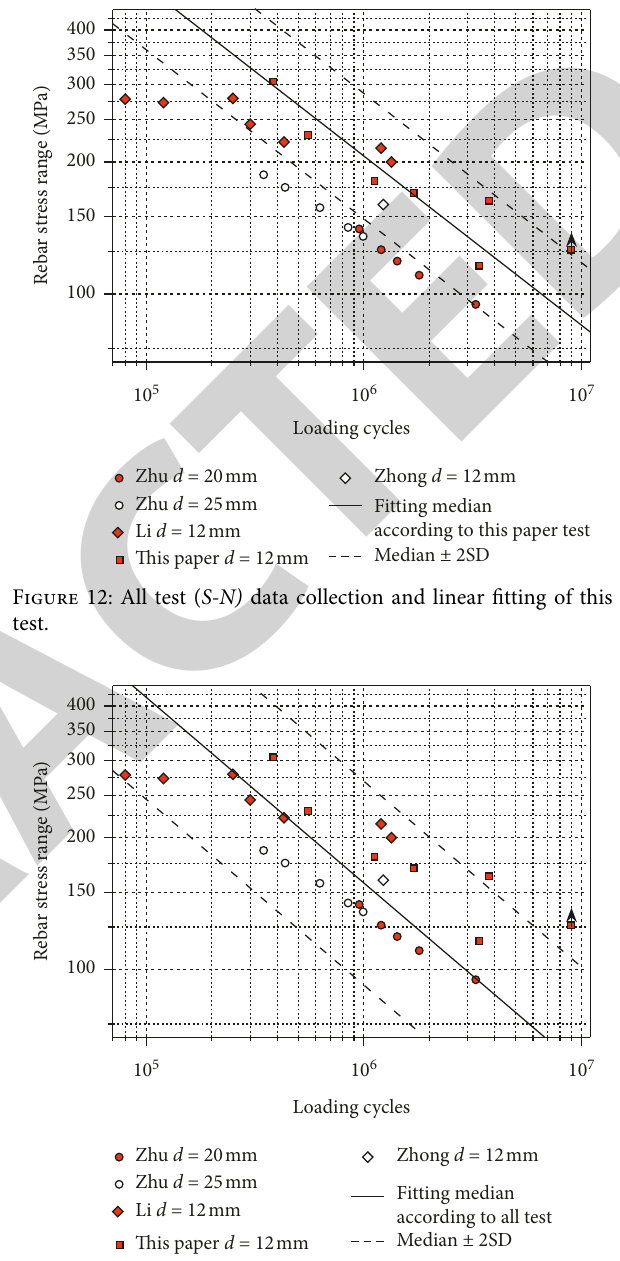
Figure 13: All test ( S-N ) data and corresponding linear